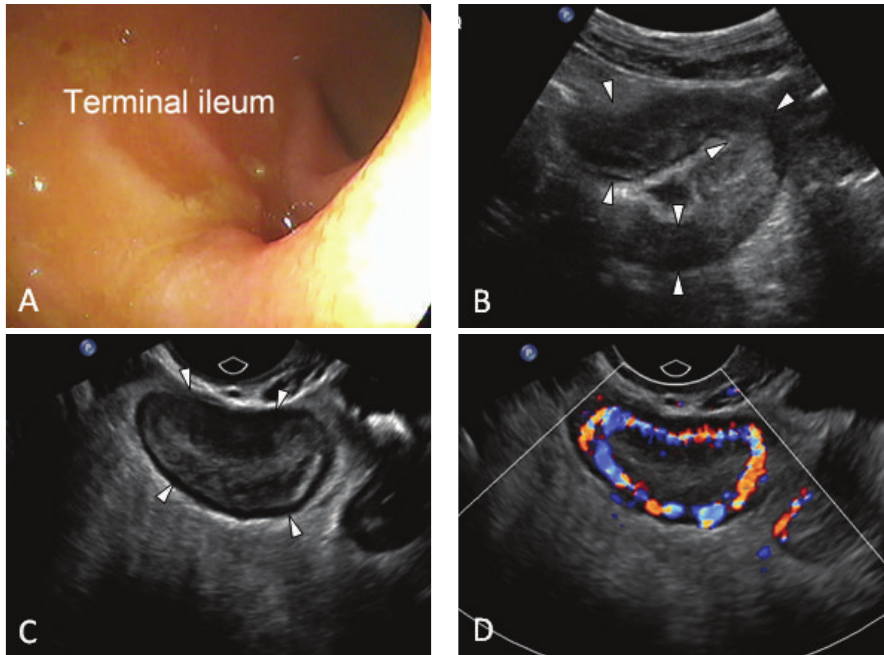
Figure 2: Negative ileocolonoscopy. 26-year-old female with 10-year history of Crohn’s disease. Ileocolonoscopy shown in (A) is normal. (B) Transabdominal ultrasound shows a proximal angulated and thickened loop of ileum (arrowheads). (C) is an endovaginal ultrasound scan showing bowel wall thickening and abundant inflammatory fat with superior resolution. In (D) the addition of colour Doppler shows profuse mural vascularity. Interpretation: severe acute inflammation of a proximal ileal loop. Systemic steroids were initiated after ultrasound.